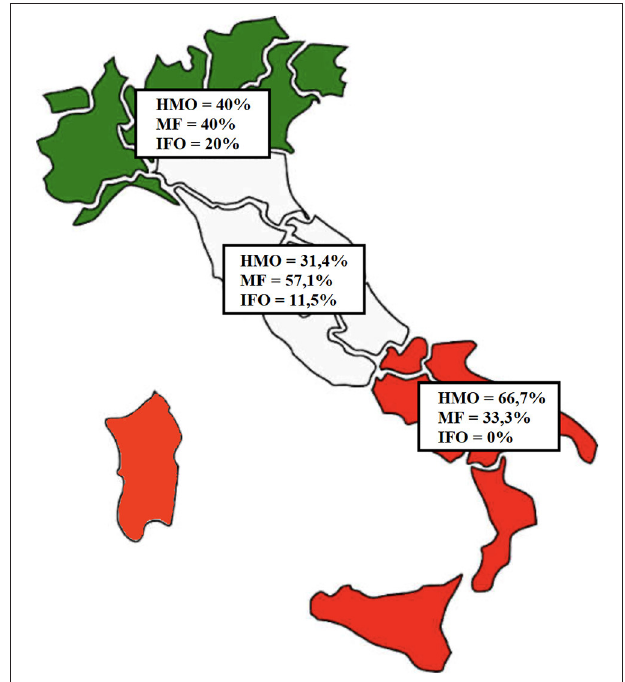
FIGURE 3 | Distribution of the patients based on region of origin. In green, Northern regions (five patients); in white, Central regions (35 patients); in red, Southern regions (12